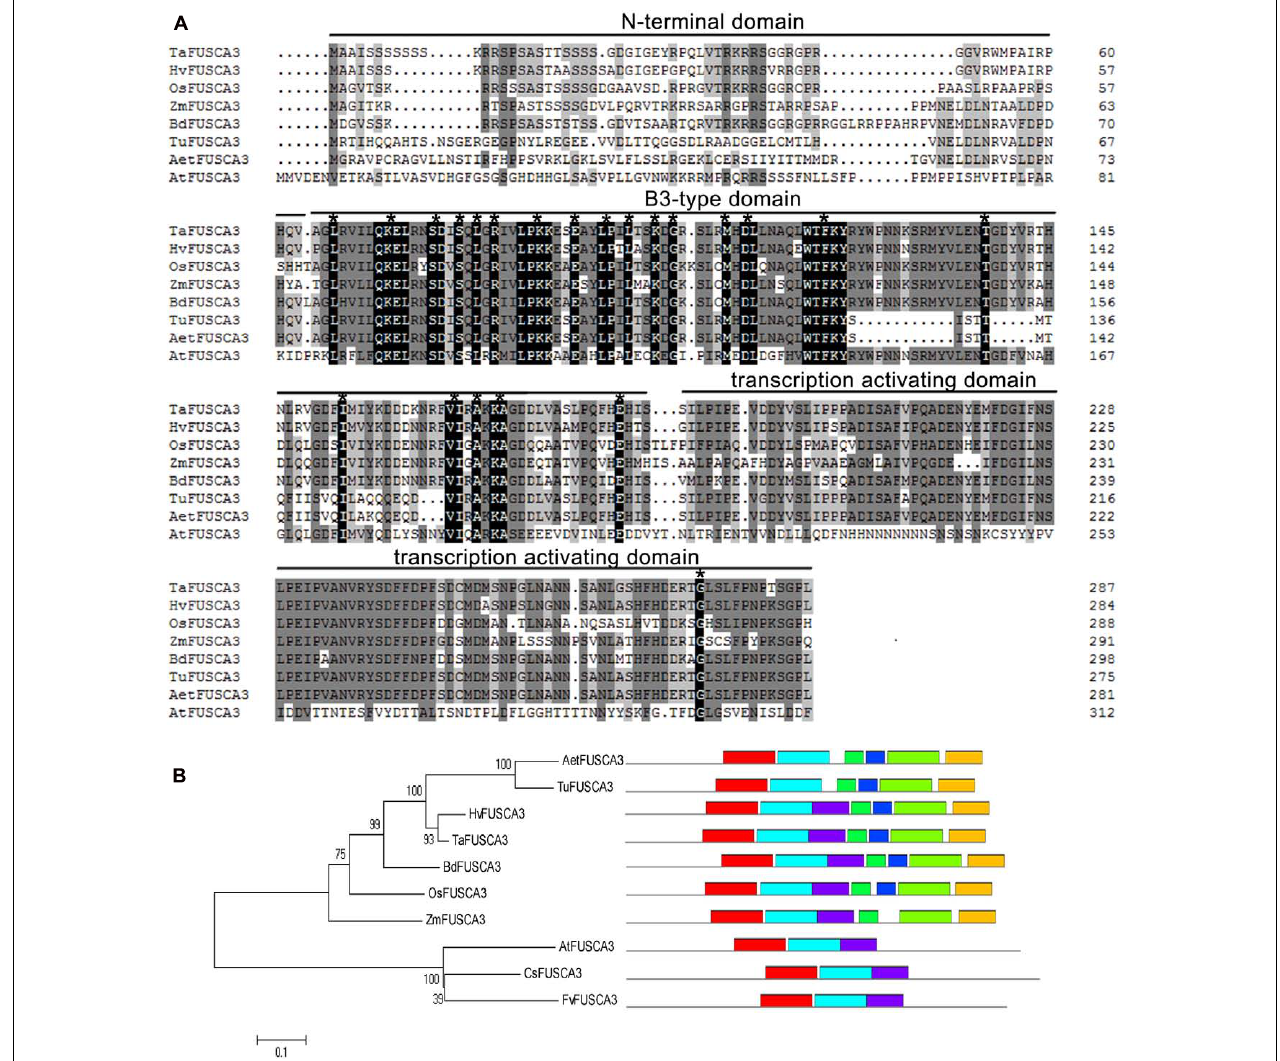
FIGURE 1 | Multiple sequence alignment and phylogenetic tree analysis of TaFUSCA3. (A) The multiple sequence alignment was performed by use of the software DNAMAN. The extremely conserved amino acid residues in all sequences are marked with asterisks. The FUSCA3 sequences from different plant species are